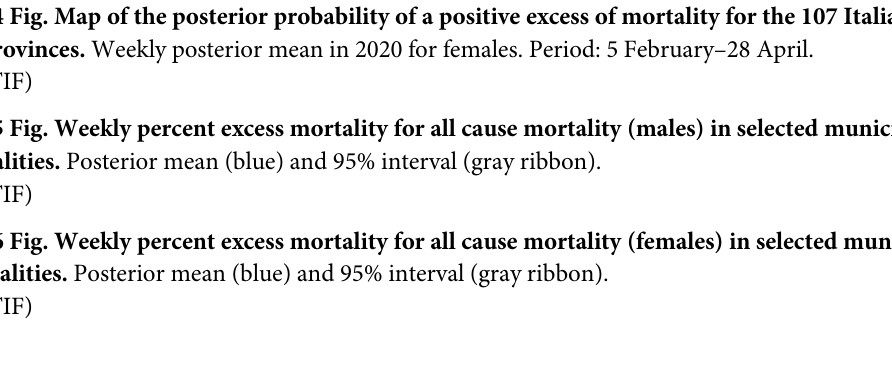
S4 Fig. Map of the posterior probability of a positive excess of mortality for the 107 Italian provinces. Weekly posterior mean in 2020 for females. Period: 5 February–28 April. (TIF) S5 Fig. Weekly percent excess mortality for all cause mortality (males) in selected munici- palities. Posterior mean (blue) and 95% interval (gray ribbon). (TIF) S6 Fig. Weekly percent excess mortality for all cause mortality (females) in selected munic- ipalities. Posterior mean (blue) and 95% interval (gray ribbon).